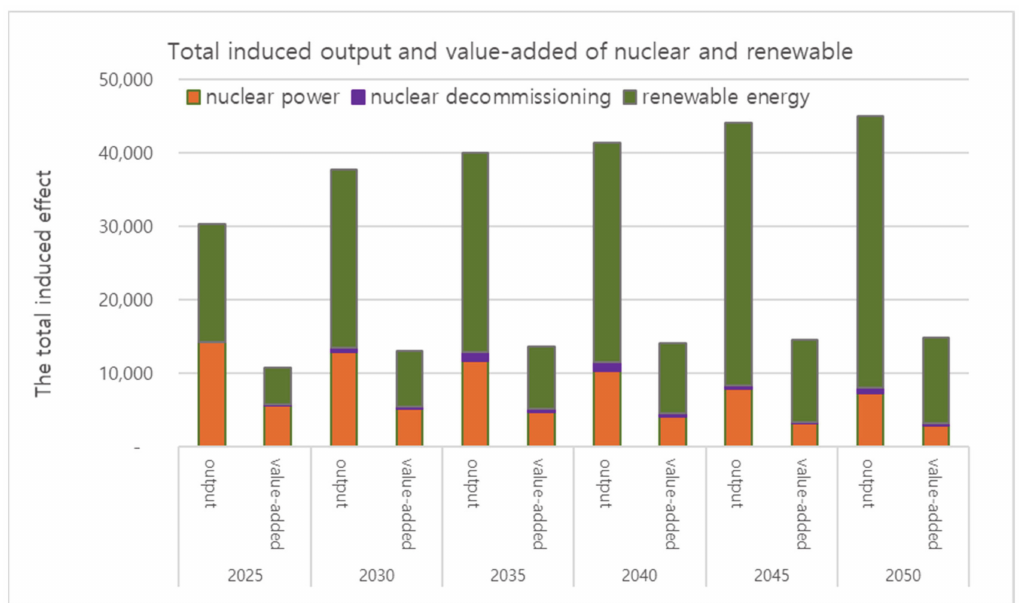
Figure 6. Total induced output and value added of nuclear phaseout and renewable power promotion. (Note: Because no more nuclear power reactors will be built, the nuclear power construction sector was not